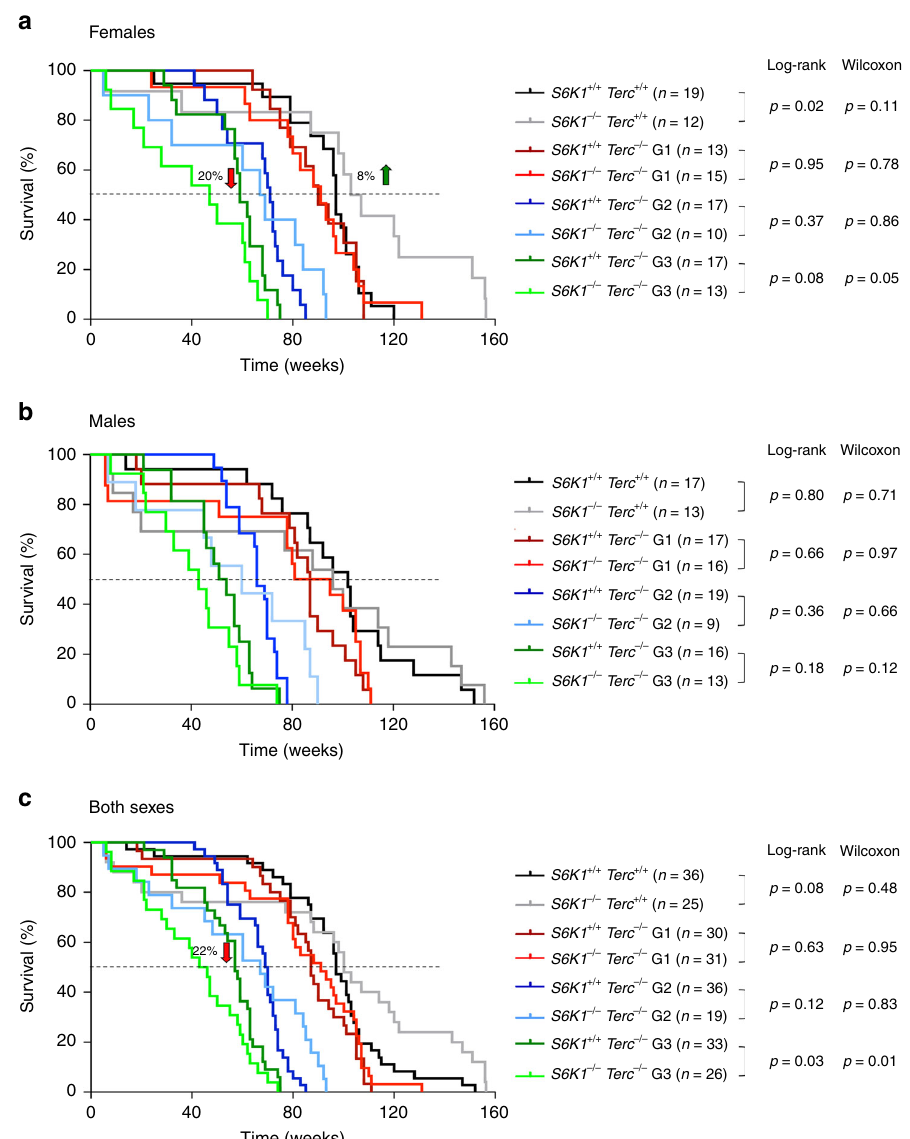
Fig. 7 Reduced survival in late generation Terc − / − S6K1 − / − mice. Kaplan – Meier survival curves of S6k1 + / + Terc + / + , S6k1 − / − Terc + / + , G1 – G3 S6k1 + / + Terc − / − , and G1 – G3 S6k1 − / − Terc − / − mice. a Females; the percentage of increase in median survival of S6k1 − / − Terc + / + mice relative to that of S6k1 + / + Terc + / + is indicated (green arrow); the percentage of decrease in median survival of G3 S6k1 − / − Terc − / − mice relative to that of G3 S6k1 + / + Terc − / − is indicated (red arrow). b Males. c Both sexes; the percentage of decrease in median survival of G3 S6k1 − / − Terc − / − mice relative to that of G3 S6k1 + / + Terc − / − is indicated (red arrow). n = number of mice. Statistical signi fi cance was determined by the log-rank test and by the Gehan – Breslow – Wilcoxon test. The p values are indicated. Source data are provided as a Source Data fi